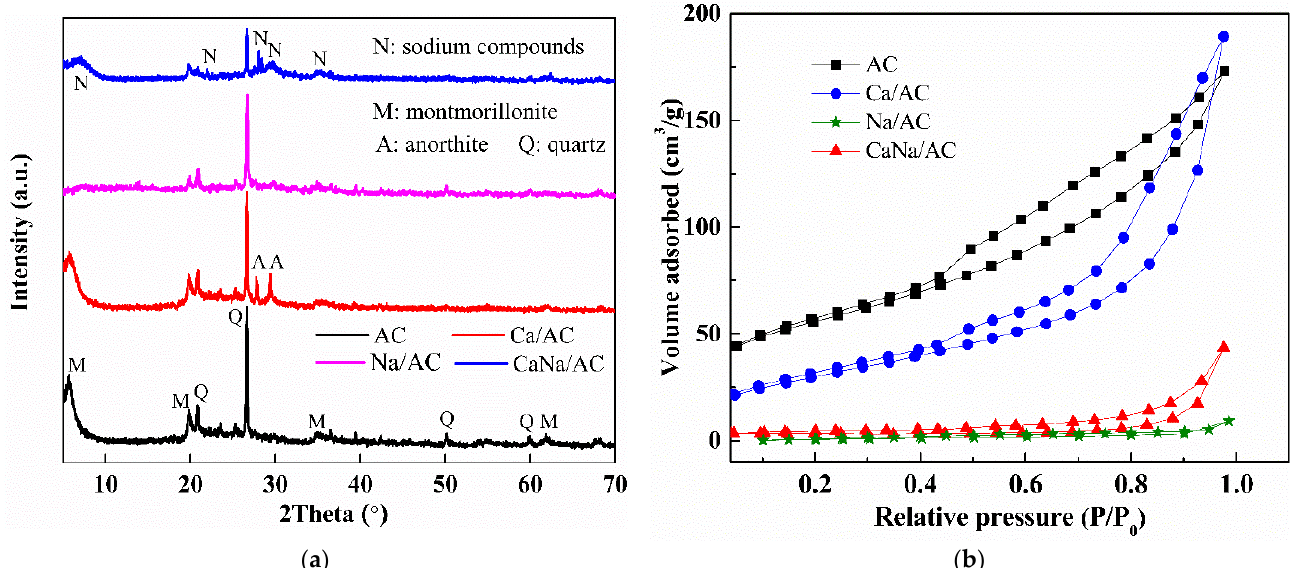
Figure 2. ( a ) The XRD patterns and ( b ) nitrogen adsorption – desorption isotherms of AC, CA/AC, Na/AC, and CaNa/AC.